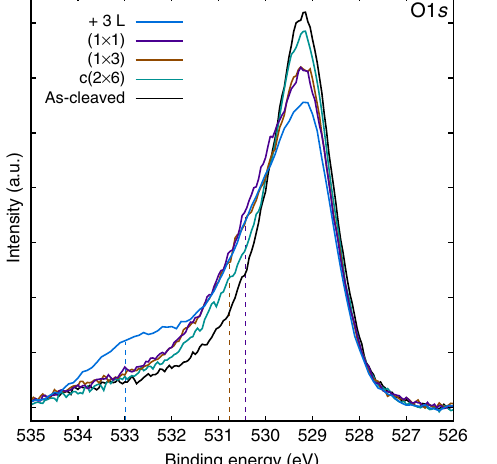
Fig. 2 O1 s XPS spectra of the as-cleaved surface and various OH overlayers observed by STM. Coverages up to and including the full monolayer lead to a shoulder between 530.0 and 531.0 eV BE for the c(2 × 6), (1 × 3) and (1 × 1) OH overlayer (full monolayer). Exposing the full monolayer to water at 105 K leads to a peak at 533.1 eV BE (labeled ‘ +3 L ’ ). In agreement with DFT calculations ( dashed vertical lines , see Supplementary Table 3), the shoulder and the peak are assigned to hydroxyls and molecular water, respectively dark (bright) lines correspond to areas where the apical oxygen atoms of the RuO 6 octahedra are tilted toward (away from) each other, see Fig. 1d. The calculated creation energies for oxygen and calcium vacancies, 3.9 and 5.3 eV, respectively, are signi fi cantly higher than the cleaving energy per broken Ca-O bond. The point defects observed in the STM images thus are attributed to impurities (Ti, Sr, Mg, Ba) in the material (see Supplementary Note 1 and Supplementary Table 2) rather than intrinsic defects that would stem from the cleaving process.